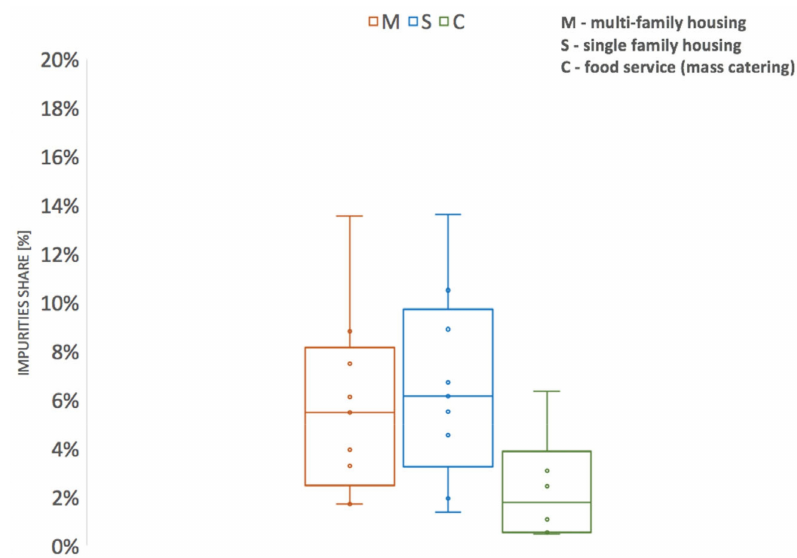
Figure 2. Impurities’ share distribution for various sources (M, S, C).